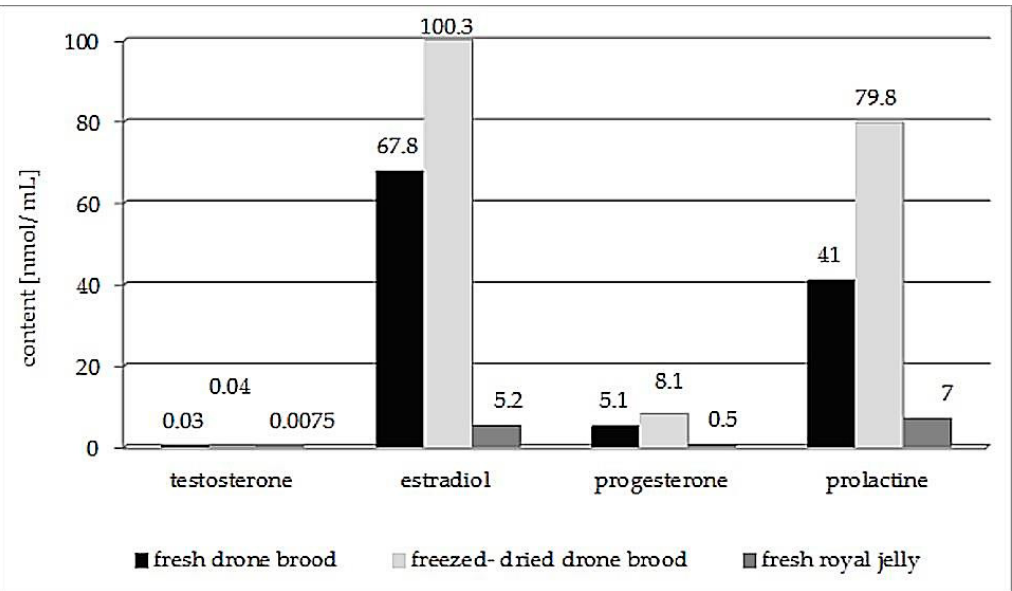
Figure 3. Hormone levels (nmol / mL) in seven-day-old drone brood compared to royal jelly [14,34,47] .